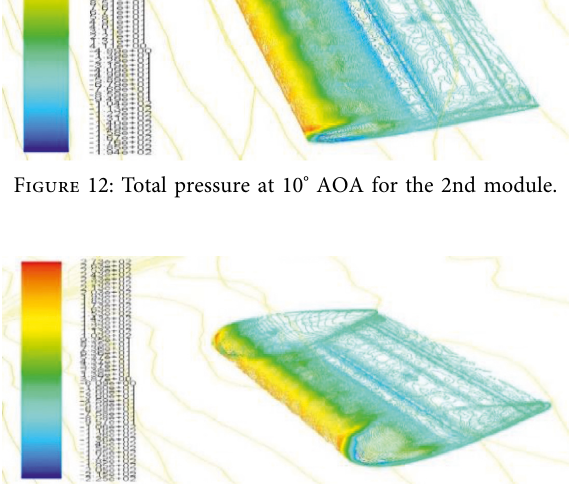
Figure 13: Total pressure at 15 ° AOA for the 2nd module.